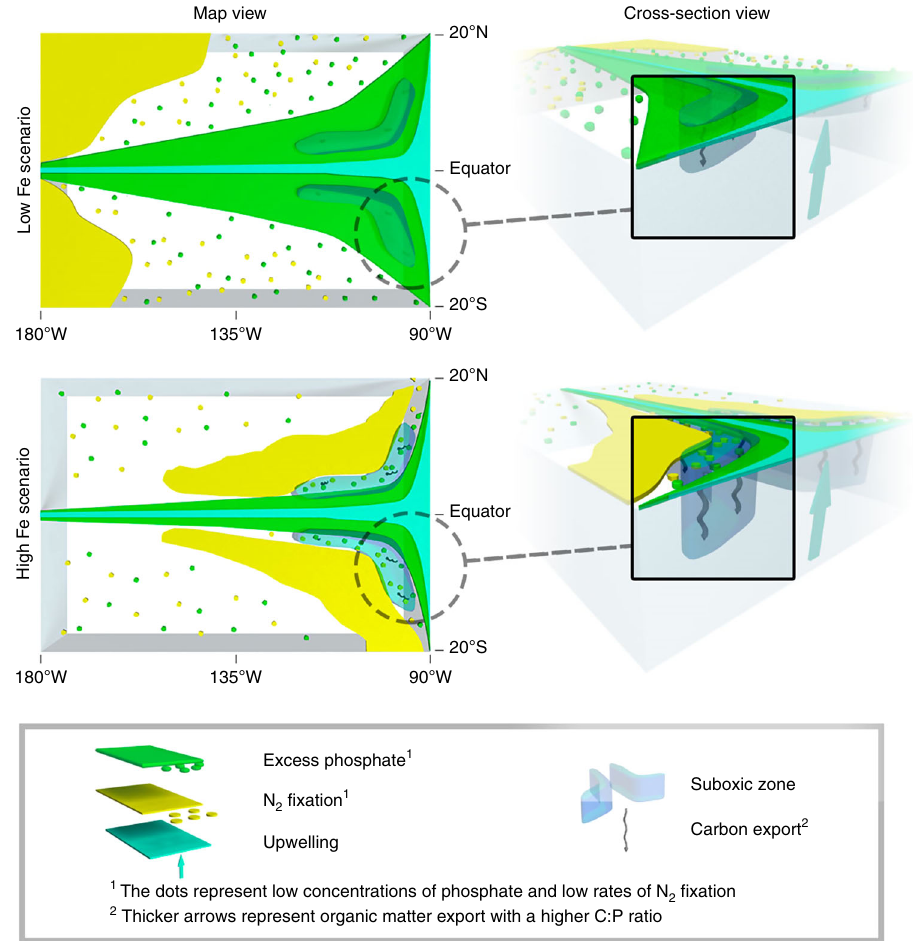
Fig. 5 Scenarios of Fe supply to the tropical Paci fi c. In the low iron scenario, analogous to the modern climate, N 2 fi xation (yellow zone and dots) is concentrated in the Northwest and Southwest subtropical Paci fi c where aeolian dust deposition is greatest. Non-limiting PO 4 concentrations (green zone and dots) exist within the tropics and spread laterally from the area of upwelling near the Americas and at the equator (blue zone). In the high Fe scenario, analogous to the glacial climate, N 2 fi xation couples to the upwelling zones in the east Paci fi c, enabling strong utilisation of PO 4 , the vertical expansion of suboxic zones (grey bubbles) and a deeper injection of carbon-enriched organic matter (downward squiggly